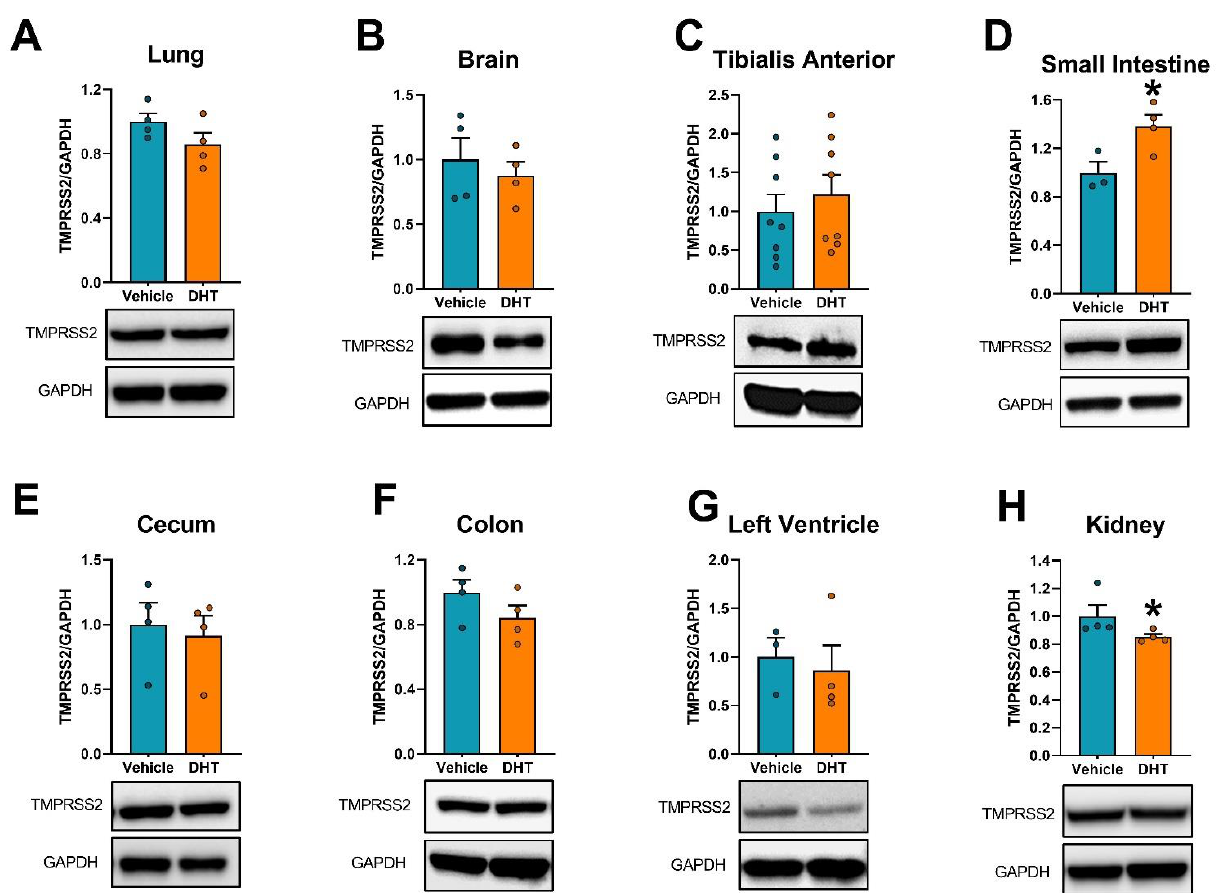
Figure 7. TMPRSS2 protein expression regulation by DHT in different tissues. TMPRSS2 protein expression was quantified by Western blot. TMPRSS2 protein expression in the lung ( A ), brain ( B ), tibialis anterior ( C ), small intestine ( D ), cecum ( E ), colon ( F ), left ventricle ( G ), and kidney ( H ) of control and DHT-treated mice. Protein expression was normalized to GAPDH and expressed relative to control mice. Data analyzed by t-test. n = 3–8/group. *: p <0.05.